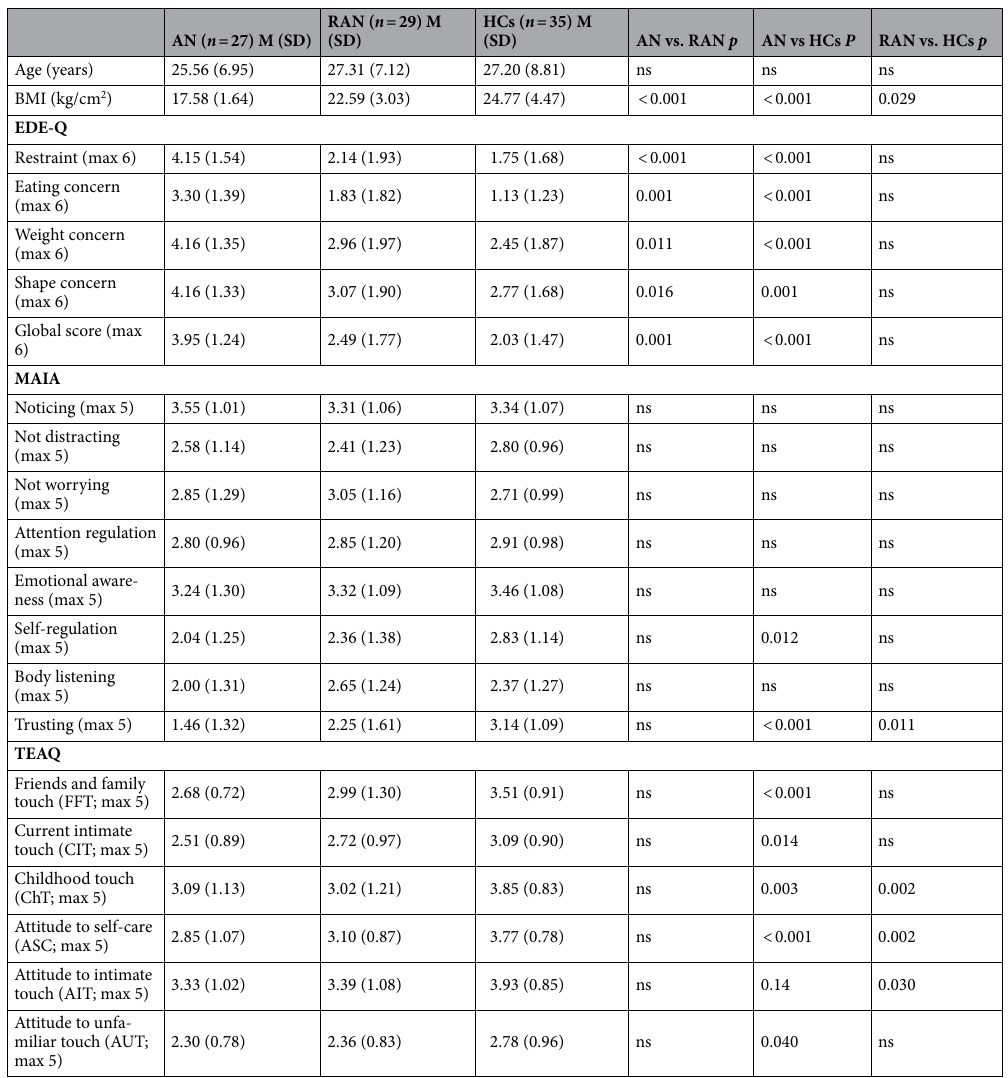
Table 1. Mean and standard deviation (in brackets) of demographics and self-report questionnaires scores for AN ( n = 27), RAN ( n = 29) and HCs ( n = 35). BMI Body Mass Index, EDE-Q Eating Disorder